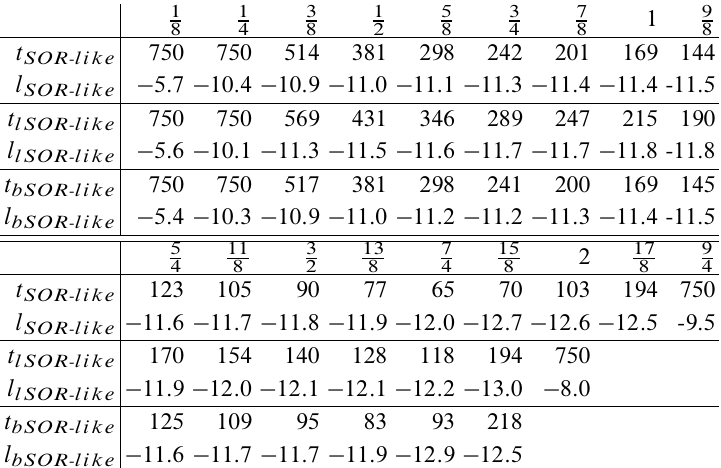
Table 4. SOR-like: numbers of iterations for tested ! , .˛ D 0/ .